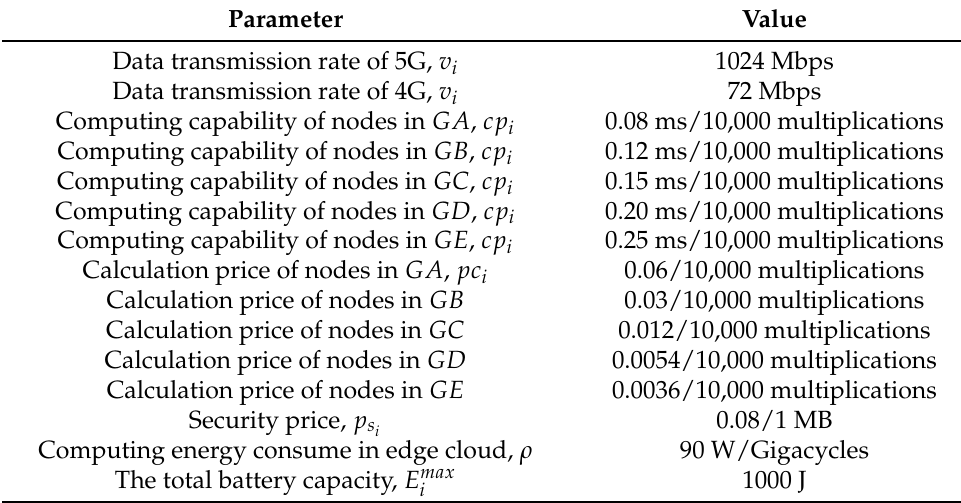
Table 3. Experimental